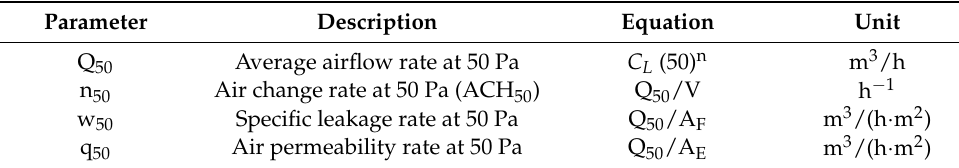
Table 1. Standardized airtightness